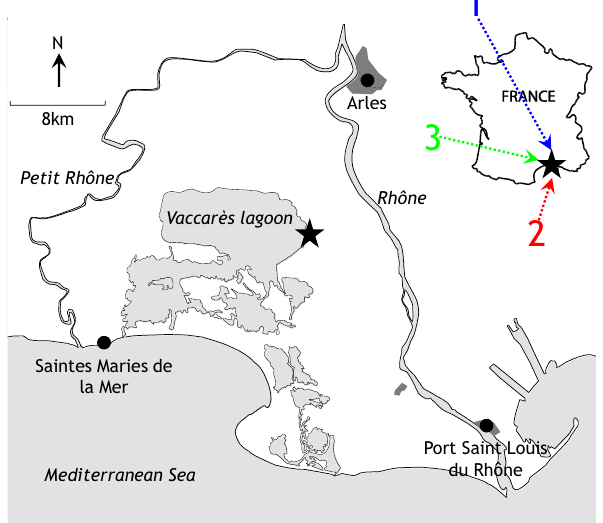
Figure 1. Location of the experimental site (star) in Camargue (Rhône River delta), 170m from the Vaccarès lagoon and 12km from the Mediterranean Sea. Coloured arrows represent the three main origins and trajectories of air masses affecting the study site, (1) North Atlantic, (2) Mediterranean and (3) Bay of Biscay.